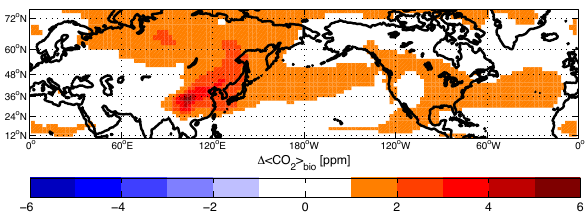
Fig. 7. Difference plot for August h CO 2 i bio resulting from zonal- mean NEE versus CASA NEE (i.e., Fig. 6d minus Fig. 6c). 1 h CO 2 i bio is generally smaller than 2ppm and exhibits a posi- tive anomaly downwind of land uptake regions. Northern hemi- spheric summer CO 2 increases by ∼ 0.1% in the simulation with zonal fluxes compared to the simulation with CASA fluxes.